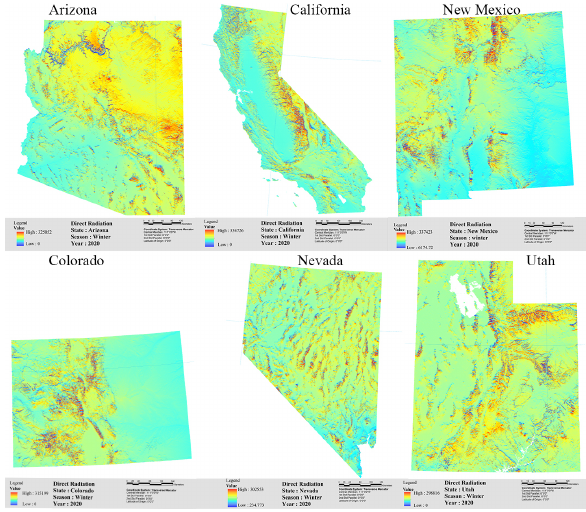
Figure 3. Solar Direct Radiation in Winter.